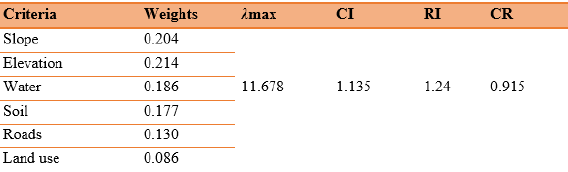
Table 5 : The computed values of weights, CI, RI, and